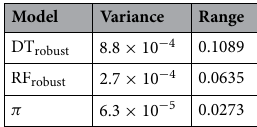
Table 4. Variance and range of feature importance for each of the